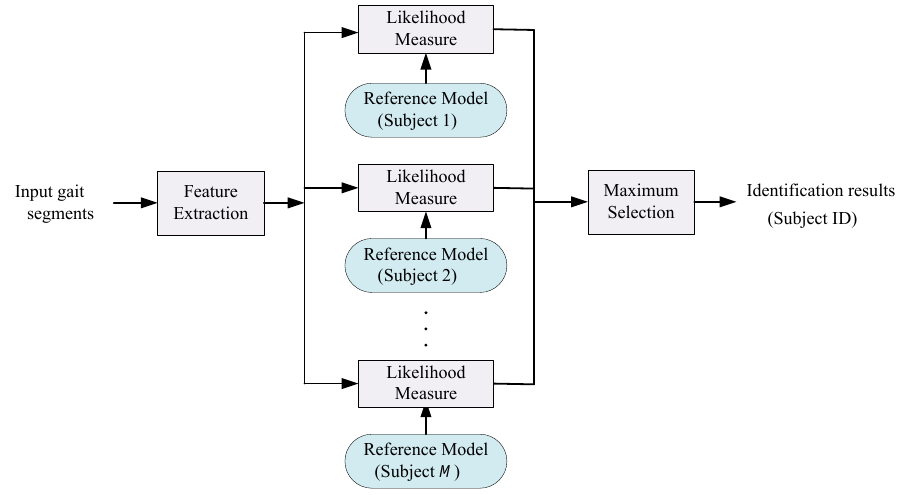
Figure 1. Human gait identification task.